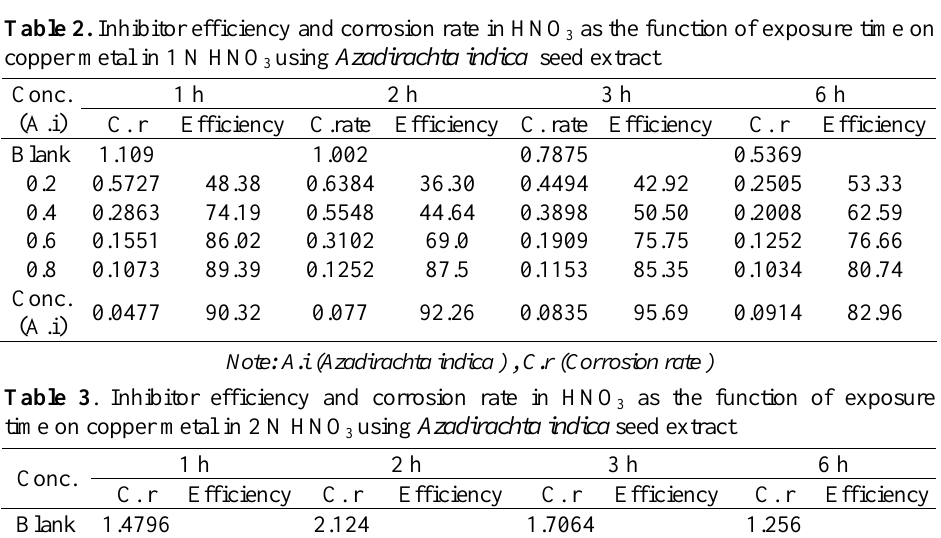
as the function of exposure time on 3